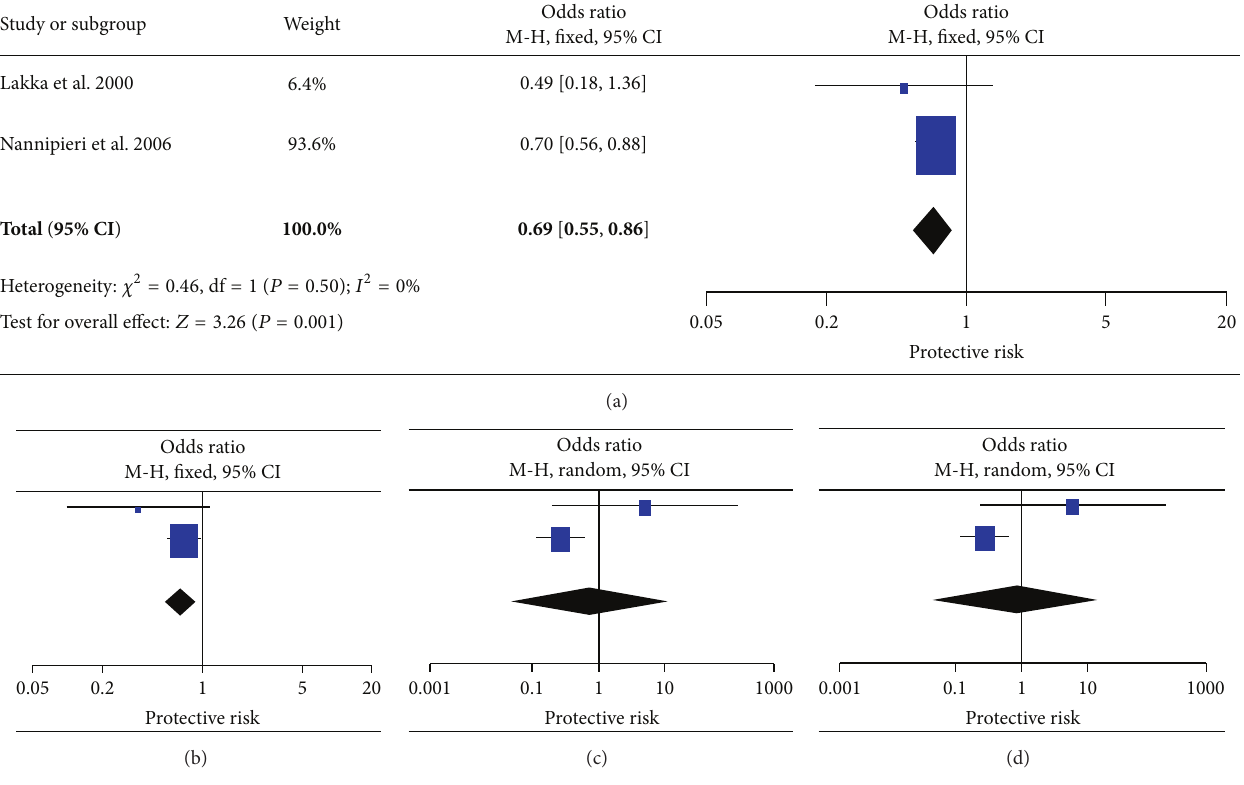
Heterogeneity: 𝜒 2 = 0.46 , df = 1 ( P = 0.50 ); I 2 = 0 % Test for overall effect: Z = 3.26 ( P = 0.001 )